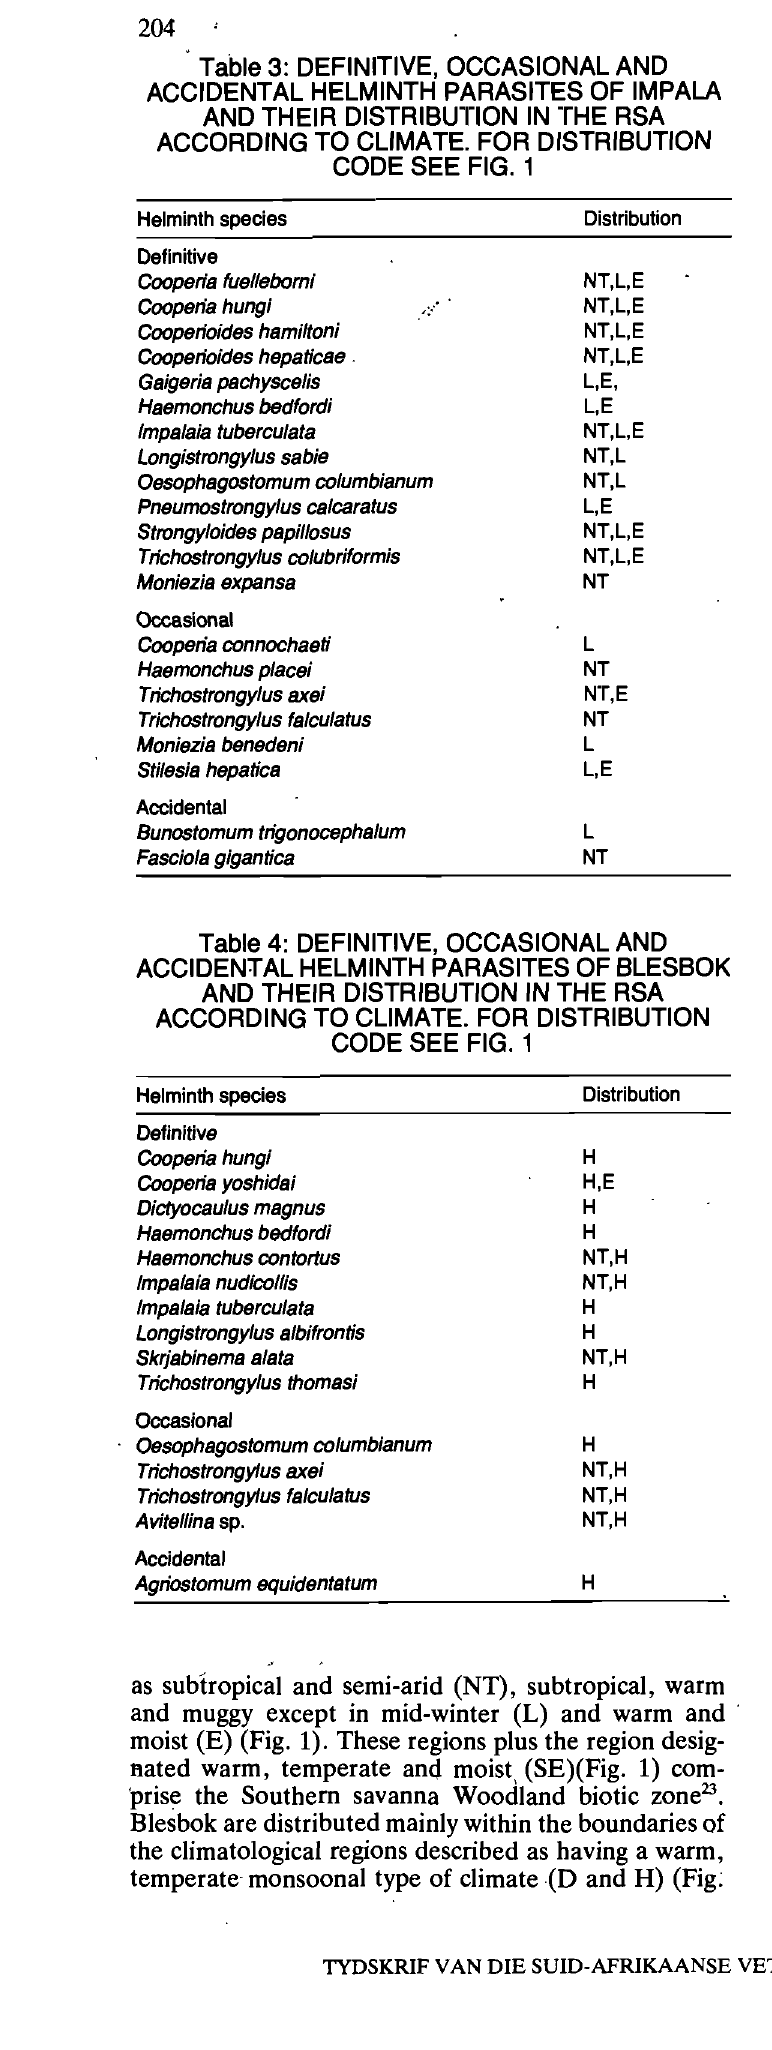
Table 3: DEFINITIVE, OCCASIONAL AND ACCIDENTAL HELMINTH PARASITES OF IMPALA AND THEIR DISTRIBUTION IN THE RSA ACCORDING TO CLIMATE. FOR DISTRIBUTION CODE SEE FIG. 1